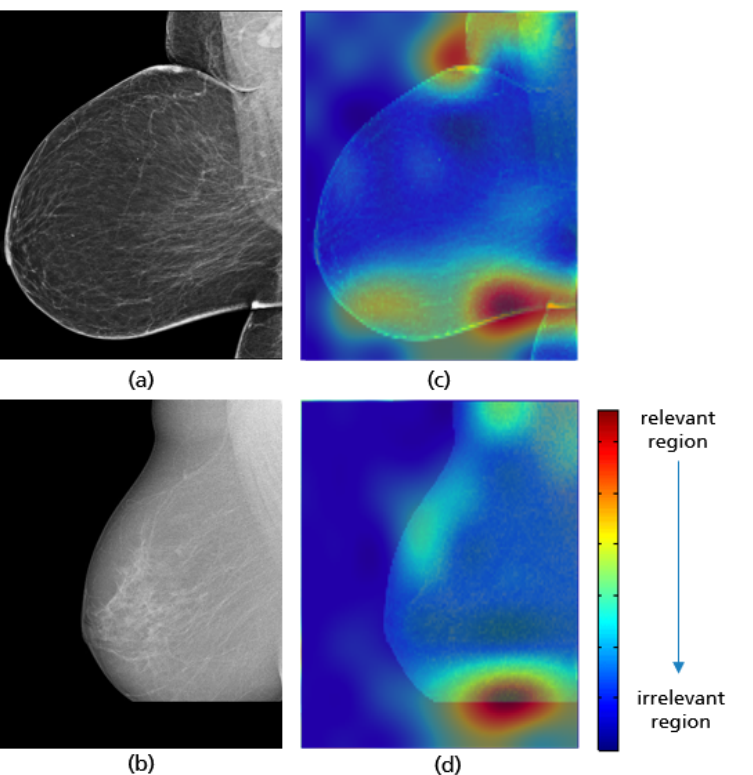
Figure 26. MLO views showing a well-positioned mammogram ( a ), an inadequately positioned mammogram with a missing breast part in the outer lower quadrant ( b ), and their Grad-CAM ( c , d ) highlighting the relevant region for the model prediction.